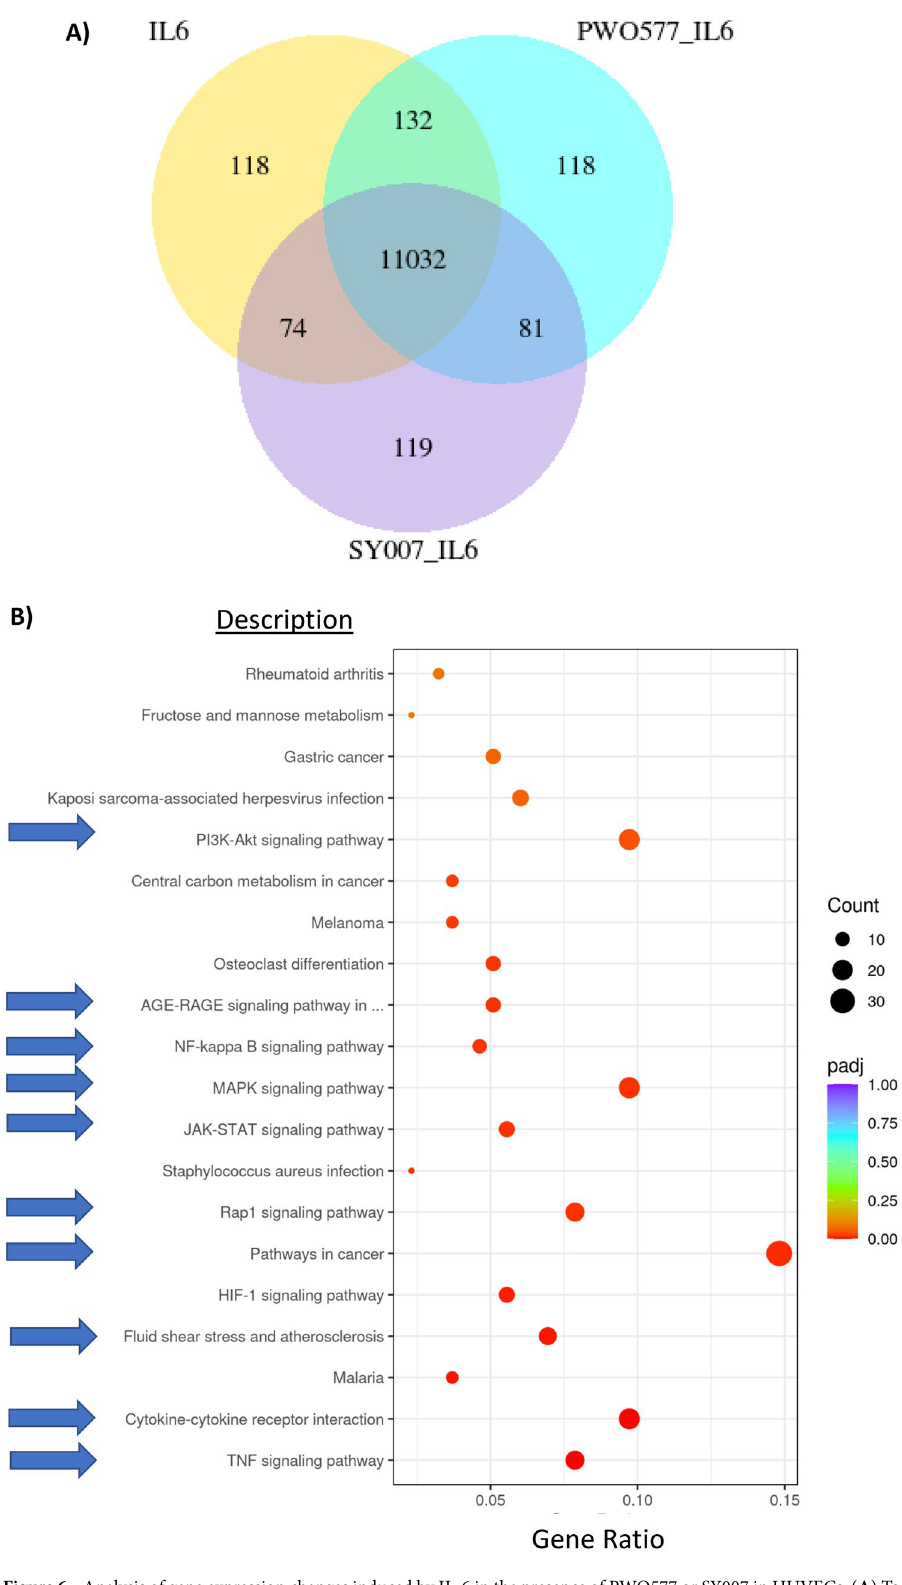
Figure 6. Analysis of gene expression changes induced by IL-6 in the presence of PWO577 or SY007 in HUVECs. ( A ) To identify regulation of IL-6 gene expression by EPAC1 activators, confluent HUVECs were stimulated for the indicated times with IL-6 (5 ng/ ml) plus sIL-6Rα (25 ng/ml) in the presence or absence of the indicated concentrations or D-007, PWO577 or SY007. Total RNA was then extracted and processed for RNAseq and plotted as a Venn diagram. ( B ) Gene expression changes from IL-6/sIL-6Rα-stimulated cells, compared to diluent treated control cells, were further analysed to identify common biological functions associated with gene expression changes by comparison with the Kyoto Encyclopaedia of Genes and Genomes (KEGG) database 51,52 . The occurrence of individual gene ontologies (Gene ratio) and their significance (p-adjust) are displayed as a dot plot. Arrows indicate the gene expression changes associated with functions associated with cytokine action, cancer and inflammatory